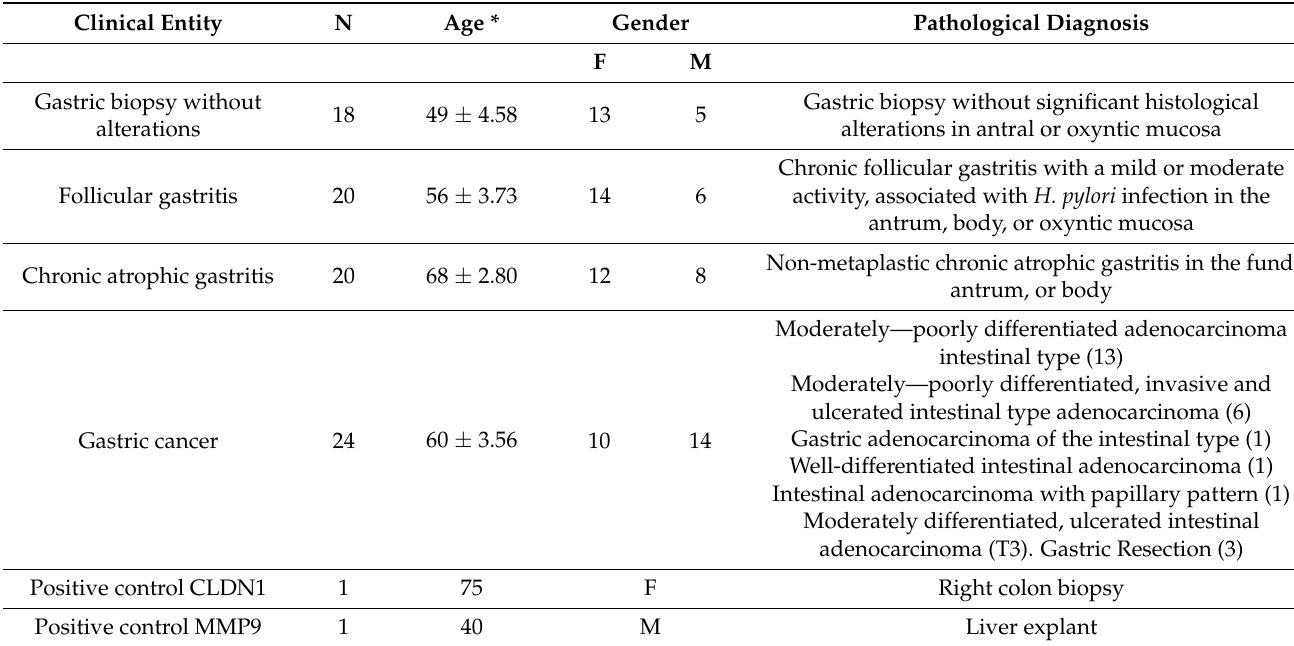
Table 6. Histopathological diagnoses of gastric biopsies used in the immunohistochemical